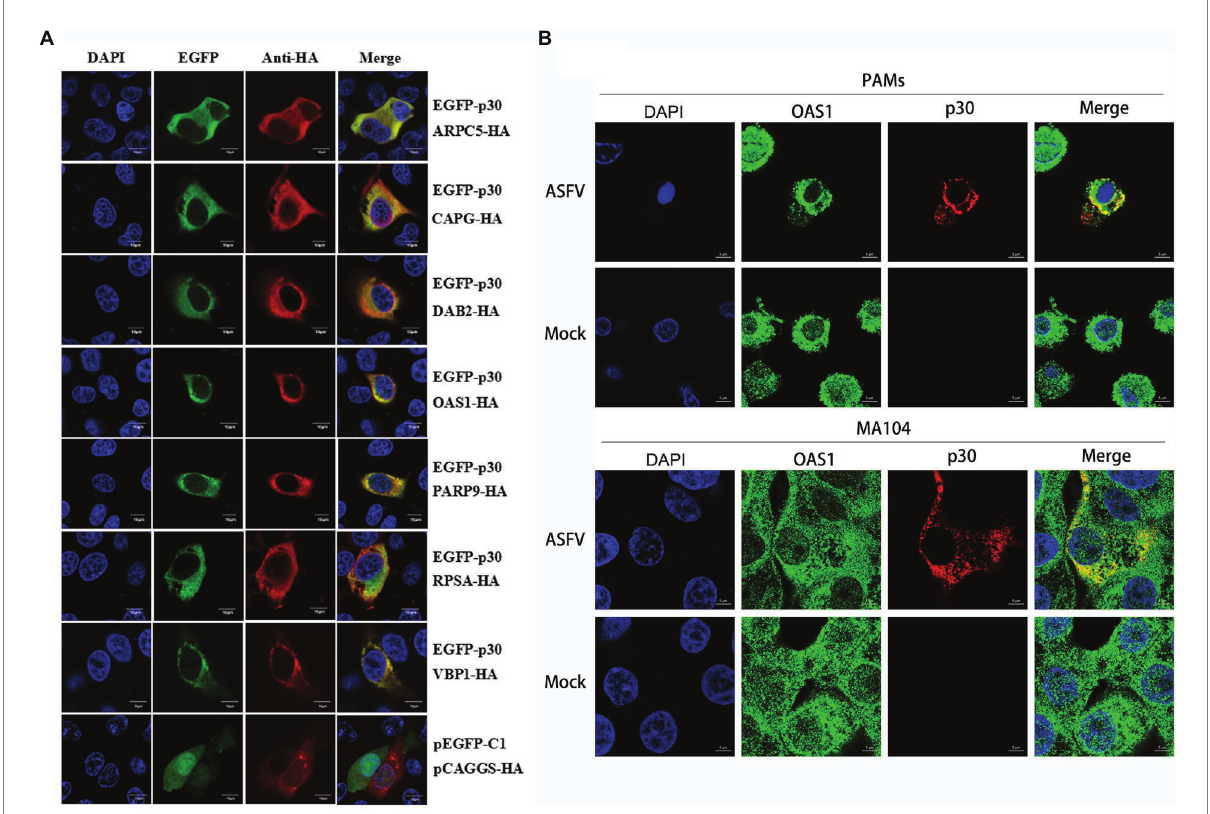
FIGURE 2 Colocalization of ASFV p30 with ARPC5, CAPG, DAB2, OAS1, PARP9, RPSA, and VBP1. (A) PK-15 cells were co-transfected with plasmids expressing HA-Dab2, HA-RPSA, HA-OAS1, HA-VBP1, HA-PARP9, HA-CAPG, or HA-ARPC5, and plasmids expressing EGFP-p30. Co-transfection of pEGFP-C1 and pCAGGS-HA as negative control. After 24 h, the cells were fixed with 4% PFA, stained with mouse anti-HA, and then examined by confocal microscopy. Scale bar = 10 μ m. (B) PAM or MA104 cells were inoculated with ASFV (MOI = 0.5). After 24 h, the cells were fixed with 4% PFA, stained with mouse anti-p30 and rabbit anti-OAS1, and then examined by confocal microscopy. Scale bar = 5 μ